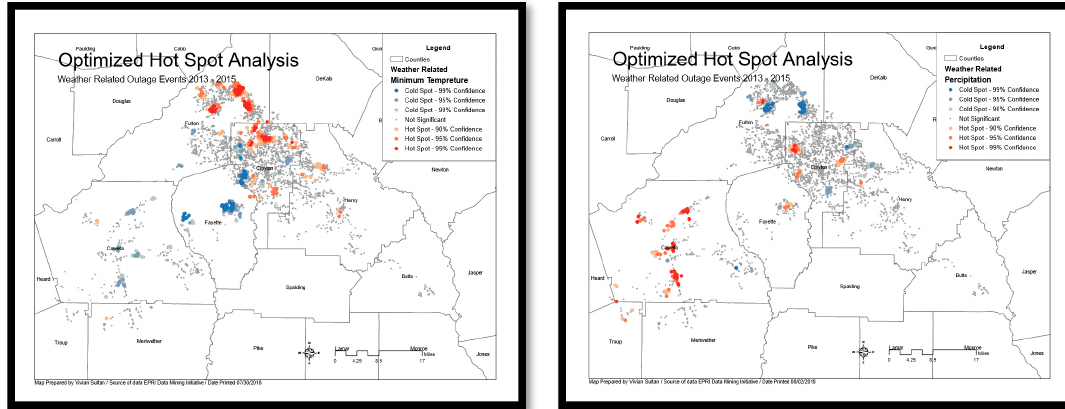
Figure 14. Spatial Analysis Level 3—Optimized Hot Spot Analysis output maps for each weather type outage events. Top left : maximum temperature; top right : mean temperature, bottom left : minimum temperature; bottom right : precipitation.